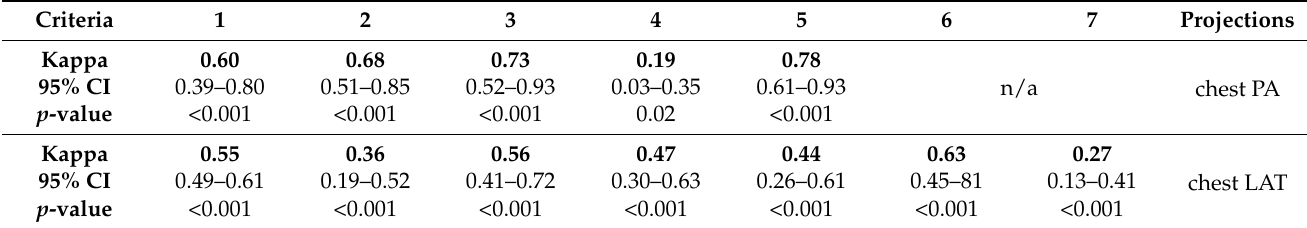
Table 6. Fleiss’ kappa assessing interobserver agreement with an asymptotic 95% confidence interval (CI) for each criterion in chest PA/LAT protocols.